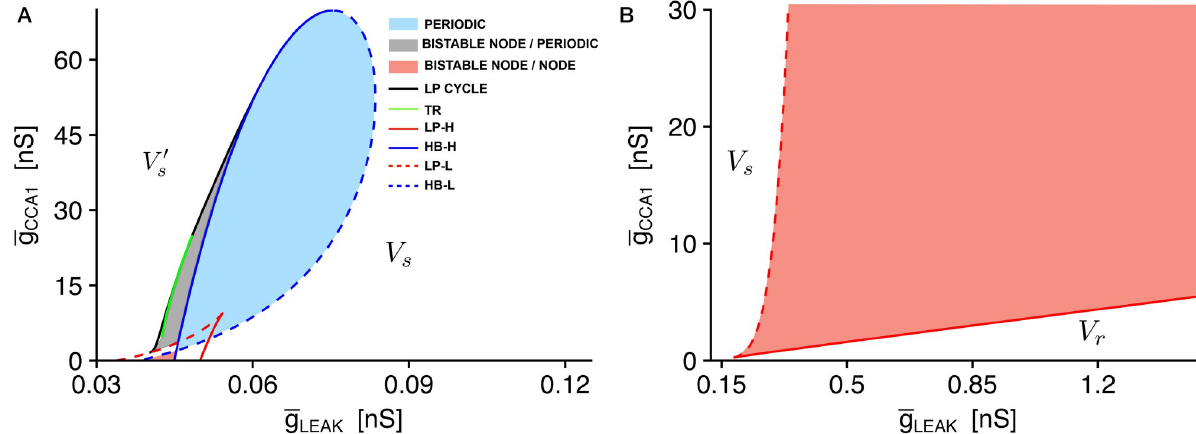
Fig 11. Bifurcation diagram in the plane � g (cid:0) � g . Fold (LP) and Hopf (HB) bifurcation curves are highlighted in red and blue respectively, LEAK CCA 1 while black and green curves denote fold and torus bifurcations of cycles (LP cycle and TR, respectively), i.e., periodic solutions of the model. A) Two- values . At low values of � g we recover the one-dimensional bifurcation diagram described in Fig 10, dimensional bifurcation diagram at low � g LEAK CCA 1 and within the red area enclosed by HB-L and HB-H the system shows bistabilty, with V s and V 0 as stable non-periodic states (nodes). At increasing s values of � g two unstable cycles originate from a fold bifurcation of cycles (LP cycle) one of which collides with V 0 in the HB-H bifurcation at CCA 1 s increasing values of � g . In the very proximity of the fold bifurcation of cycles, the larger periodic solution gains stability via a torus bifurcation (TR). LEAK In between TR and HB-H bifurcations, the system shows a different kind of bistability, characterized by the coexistence of V 0 and a stable periodic s solution (gray area). At higher values of � g , on the right of HB-H, only the oscillatory solution survives (blue area), which eventually disappears LEAK through the HB-L bifurcation. White areas in the diagram denote the presence of a unique stable steady-state, V 0 and V at low and high values of � g , s LEAK s respectively. B) Two-dimensional bifurcation diagram at high � g values . Below the LP bifurcation at low voltage (LP-L, red dashed line), there is a LEAK unique stable state V , while after the bifurcation curve a second stable state V appears, together with an unstable state V . Further increasing � g , the s r u LEAK stable state V coalesces with V in a second LP bifurcation at high voltage (LP-H, red continuous line), making the system collapse in the unique stable s u state V r . The bistability regime is guaranteed within the red